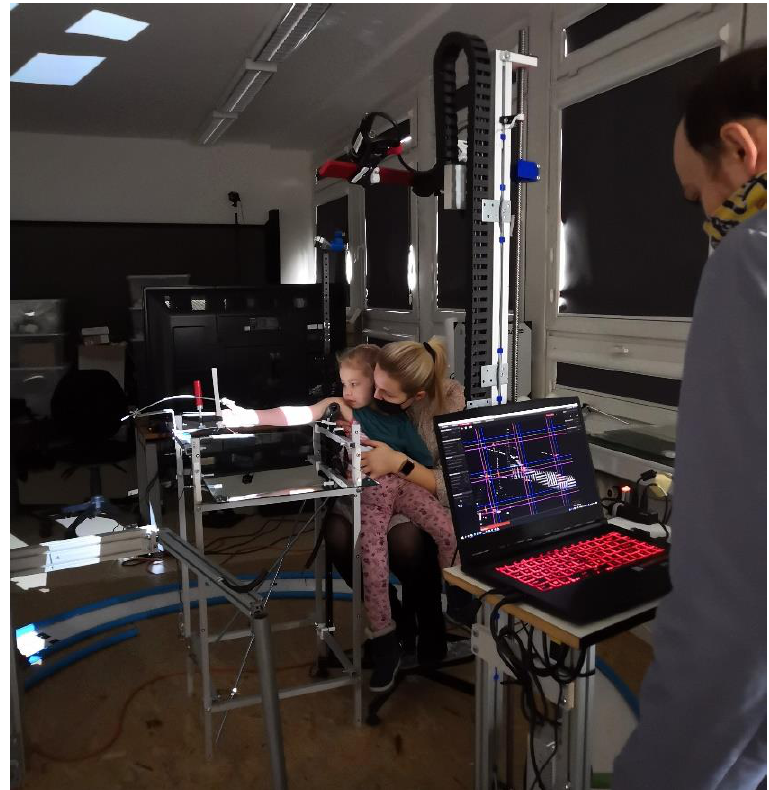
Figure 2. Use of the AutoMedPrint system — 3D scanning of a patient.